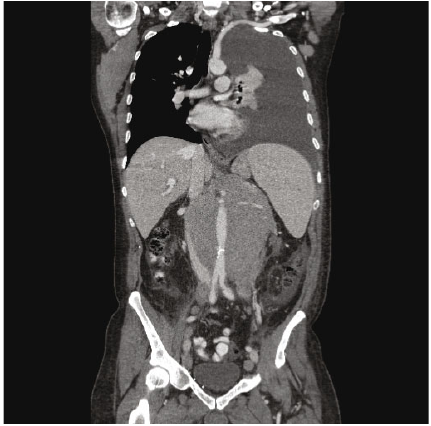
Figure 1: Coronal view of the chest with a large malignant pleural e ff usion.